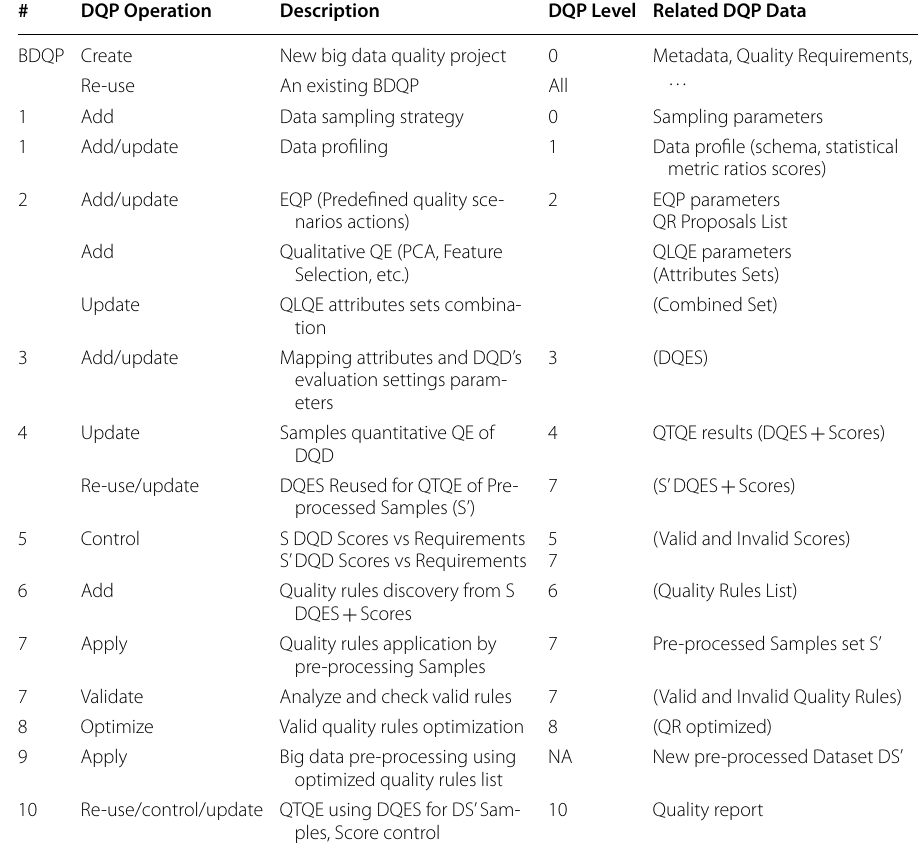
Table 6 Data quality profile